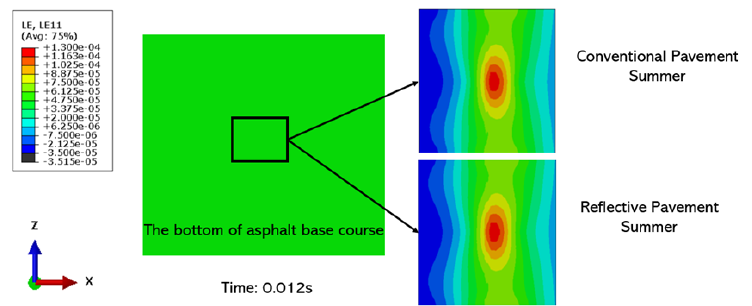
Figure 12. Distribution of logarithmic horizontal strain of the conventional and cool pavements.